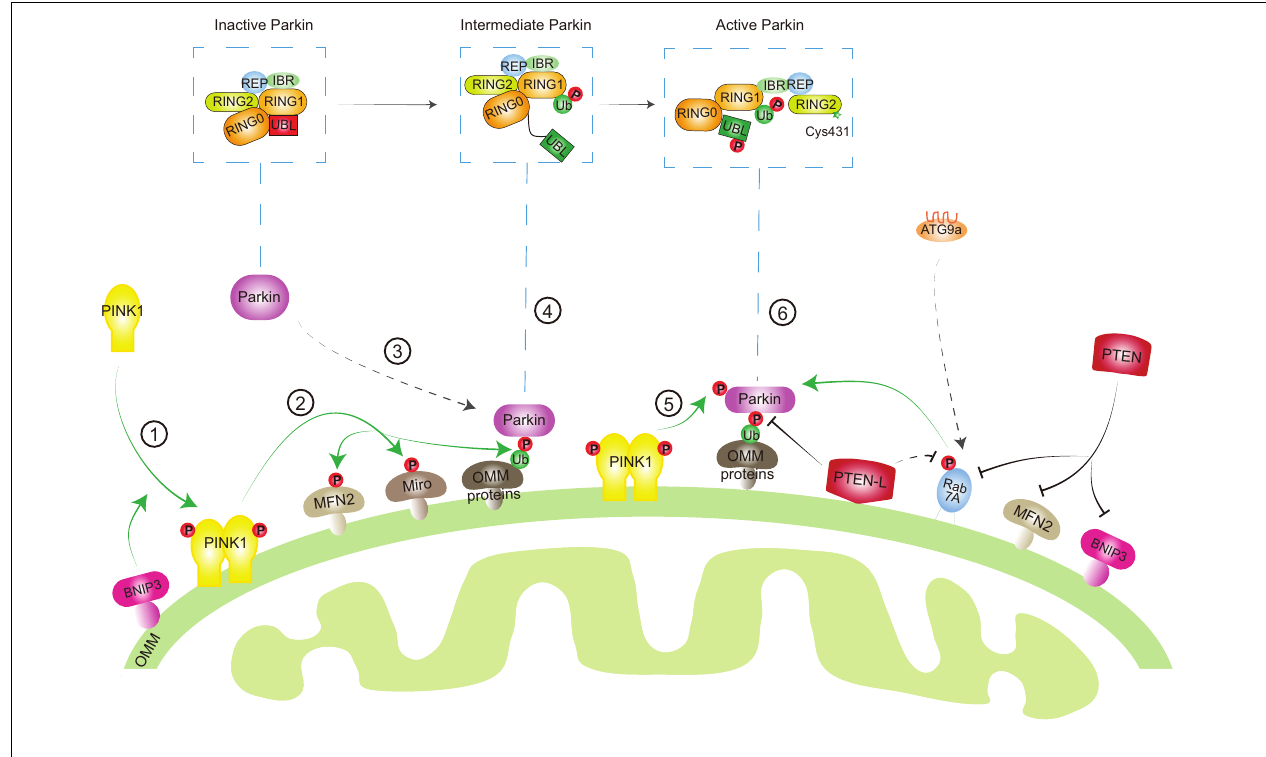
FIGURE 2 | Key effectors involved in mitophagy machinery. When mitochondria are healthy, phosphatase and tensin homolog-induced kinase protein 1 (PINK1) is imported into the mitochondria, cleaved by protease, and degraded by proteasome, while Parkin keeps in an inactive conformation in the cytosol through intradomain–domain interactions. Upon mitochondrial damage or depolarization, PINK1 is stabilized and activated at the outer mitochondrial membrane (OMM) (cid:192) , which leads to the phosphorylation of its downstream targets, such as ubiquitin (Ub) (cid:193) . Parkin has a high affinity to phosphorylated Ub (pSer65-Ub), which recruits Parkin from cytosol to mitochondria (cid:194) . Several other factors, such as mitofusin 2 (MFN2), Miro, Rab7A, as well as BCL2/adenovirus E1B 19 kDa protein-interacting proteins 3 (BNIP3) are also involved in Parkin mitochondrial recruitment. Binding to pSer65-Ub releases the Ub-like (UBL) domain of Parkin from RING1 domain, partially activating Parkin (cid:195) . Then, PINK1 phosphorylates the UBL domain at Ser65 (cid:196) , which drives the phospho-UBL to rebind to the RING0 domain of Parkin to expose RING2 (cid:48) catalytic site (Cys431) and fully activate Parkin (cid:197) . On the other hand, phosphatase and tensin homolog long (PTEN-L) located at OMM dephosphorylates Ub to inhibit mitophagy, whereas PTEN in the cytosol suppresses mitophagy through targeting Rab7A, MFN2, or